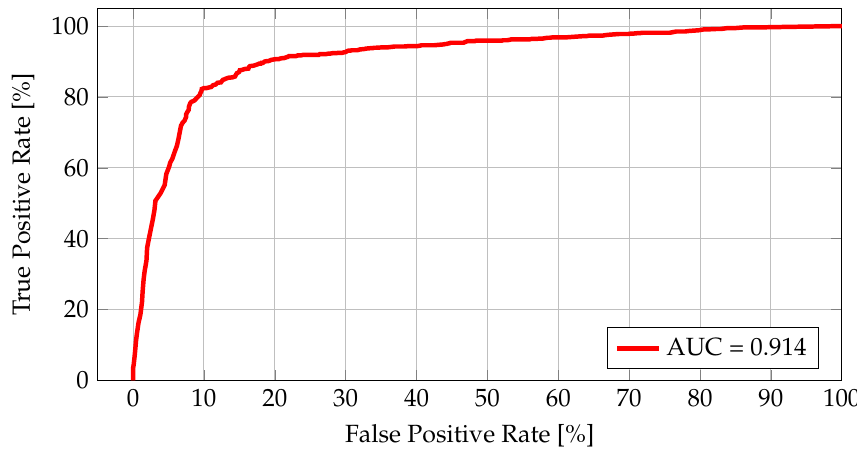
Figure 11. Receiver operating characteristics for